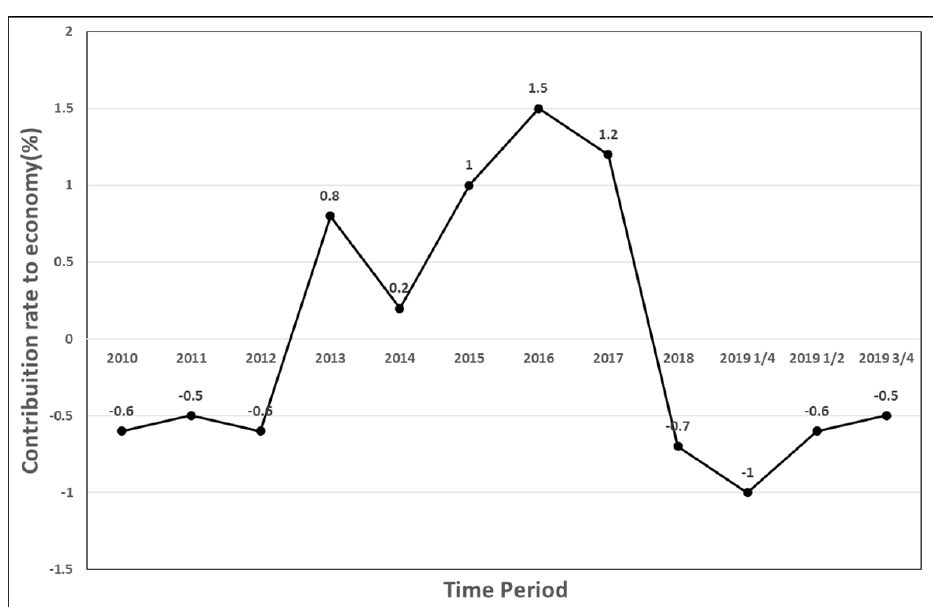
Figure 1. Contribution of the construction industry to the economic growth.